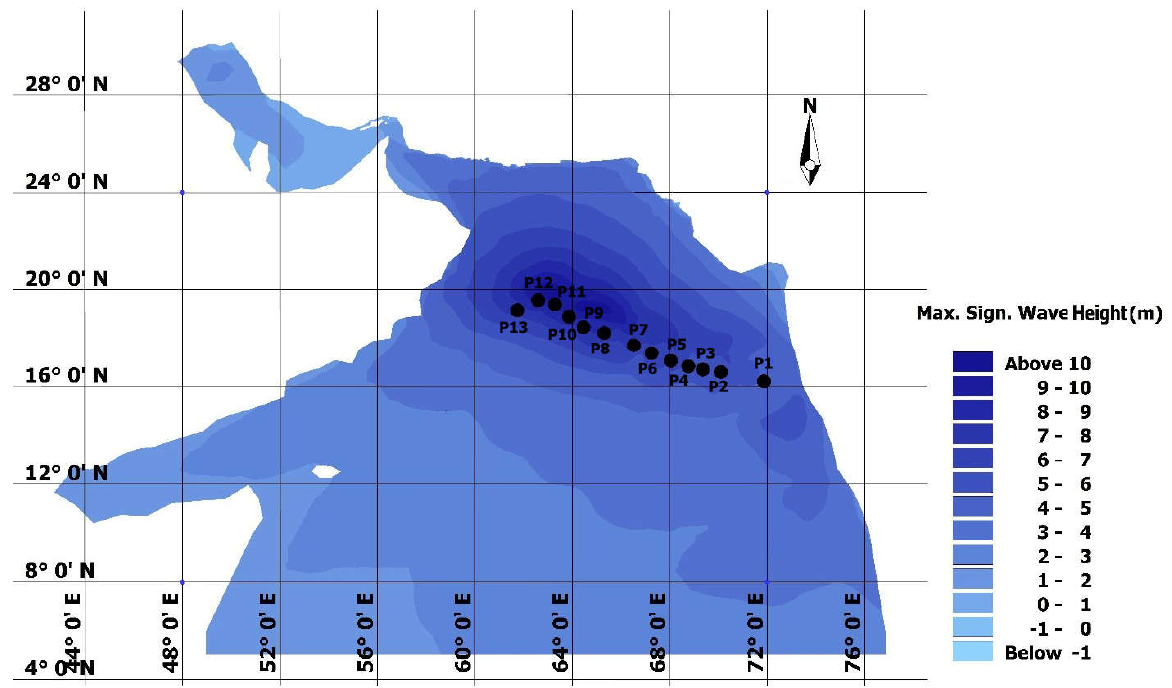
Figure 10. Optional points along tropical cyclone Kyarr.